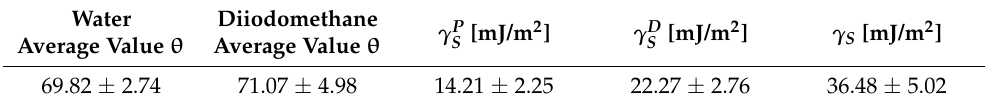
Figure 5. Photos of Kap 7 ball: surface ( a ) 10×, ( b ) 30×, cross-section photos ( c ) 10×, ( d ) 30×. Table 2. The surface free energy for the Mikasa sample.